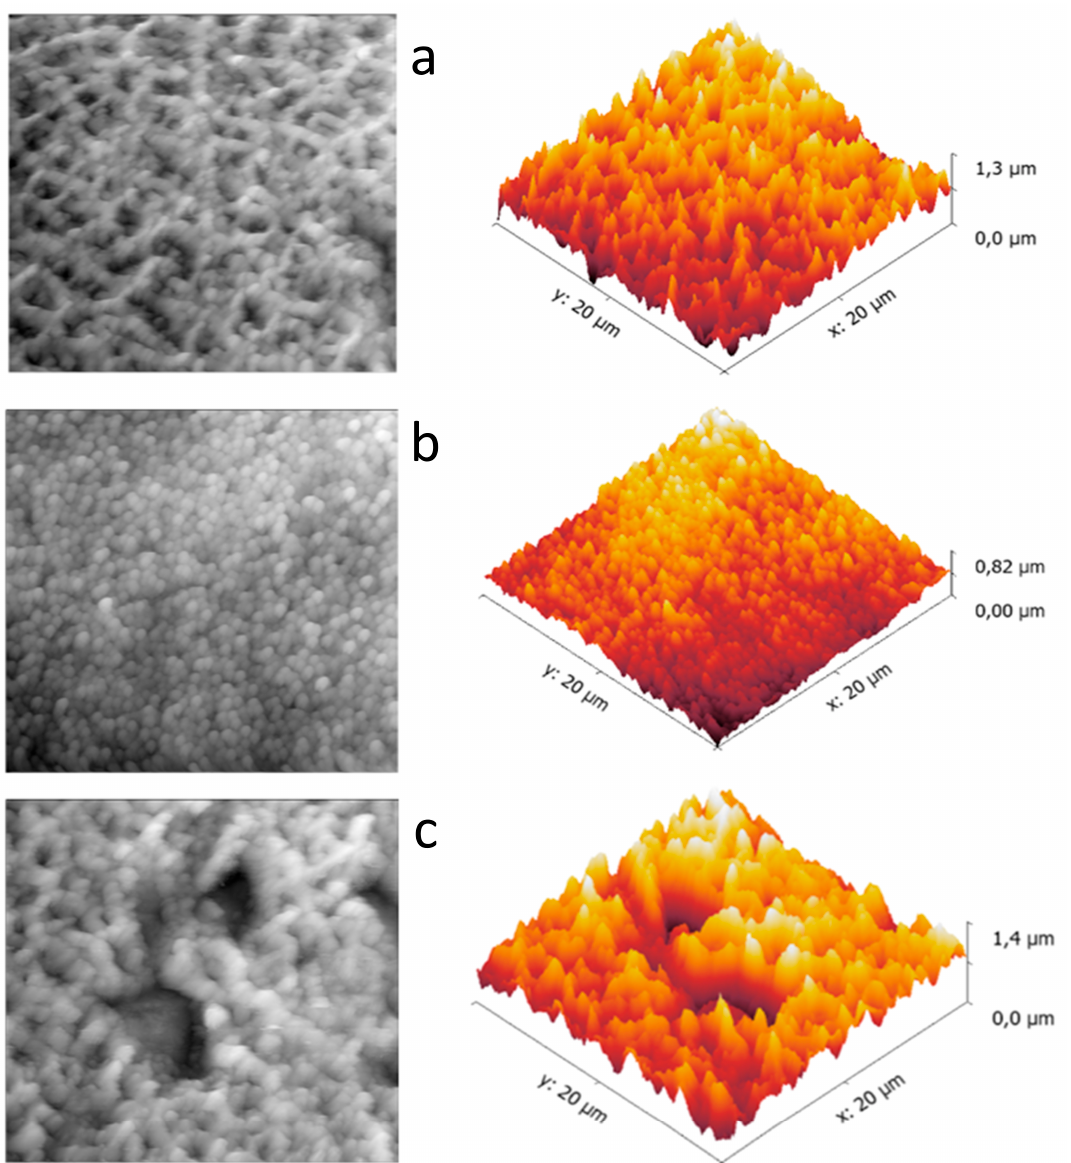
Figure 4. Nano-morphology (2D images on the left and 3D reconstructions on the right) of the disk surface at different production step: ( a ) after etching and silanization (NaOH + VapAPTES), ( b ) after etching, silanization and sericin bioconjugation with glutaraldehyde (NaOH + VapAPTES + GLU), ( c ) after etching, silanization and sericin bioconjugation with EDC/NHS (NaOH + VapAPTES + NDC/NHS). Atomic force microscopy, semi-contact mode.